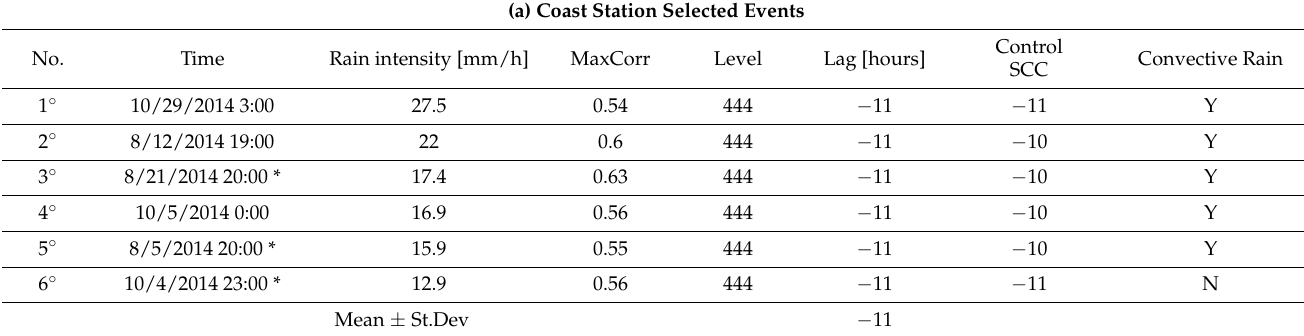
Table 5. Events of interest arranged in descending order of magnitude (first column) with the corresponding date and time, rain intensity, wavelet decomposition levels with the max. correlation, lag, control cross-correlation parameter of the time series, and the presence or not of convective clouds registered by satellite images as Y = Yes, N = No, Not Available = NA, Minimum = M. The data sets of events marked with * were truncated to prevent overlapping, for (a) Coast, (b) Andes Valley 1, (c) Andes Valley 2, (d) High mountain and (e)